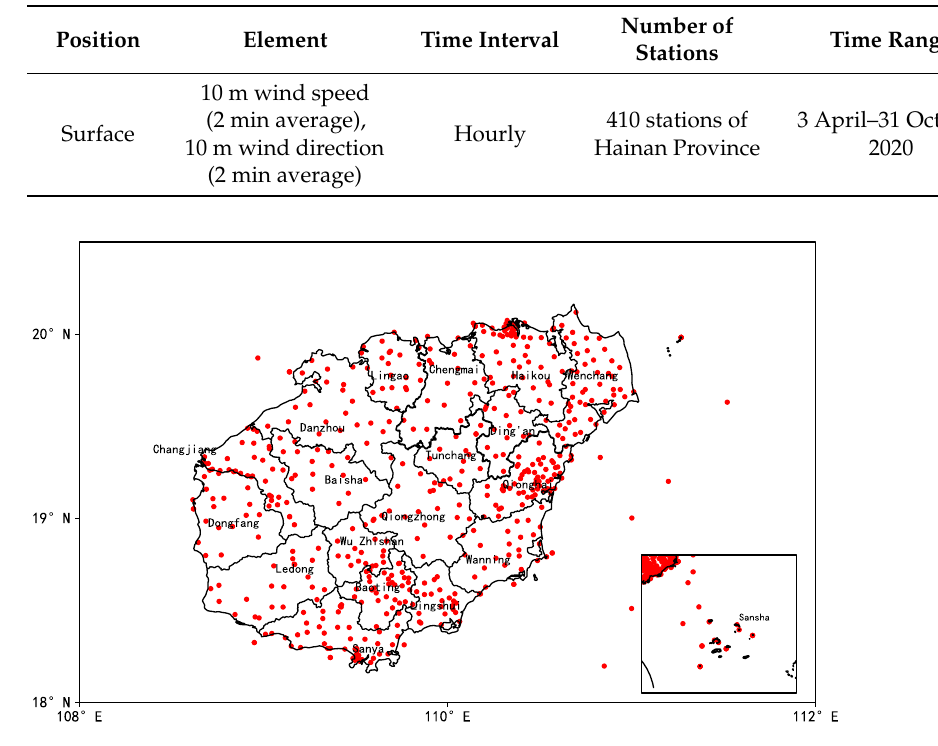
Figure 1. Distribution of ground automatic meteorological observation stations in Hainan Province.